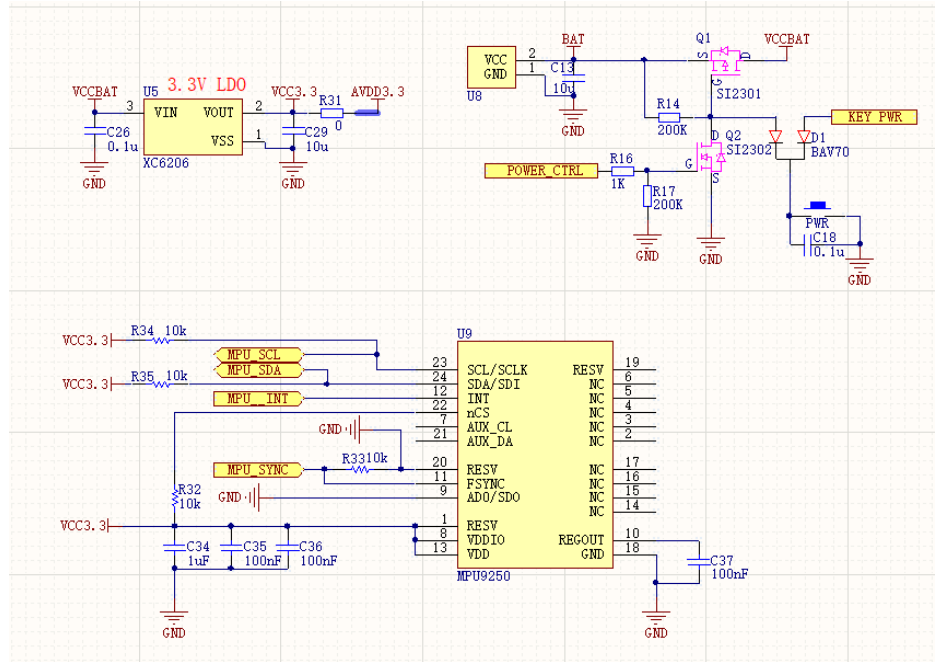
Figure 5. sEMG hardware using mpu9250 for motion monitoring.